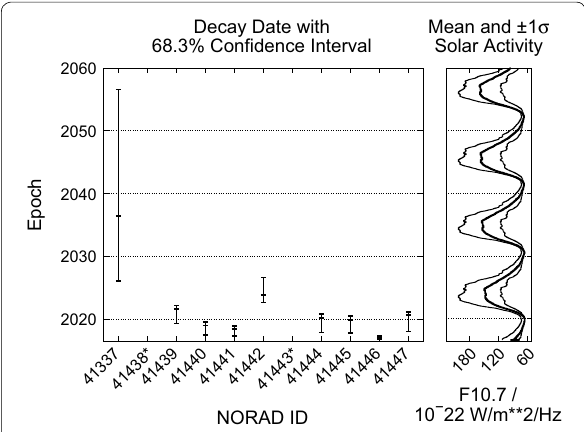
Fig. 6 Predicted orbital lifetime for all debris originating from Hitomi ( left ). The ‘*’ indicates objects which have already decayed. Error bars are given for the span of remaining orbital lifetime corresponding to the 68.3% confidence interval for the solar activity magnitude ( right ). Solar activity and remaining orbital lifetime predictions were performed using ESA’s DRAMA software v2.0.1